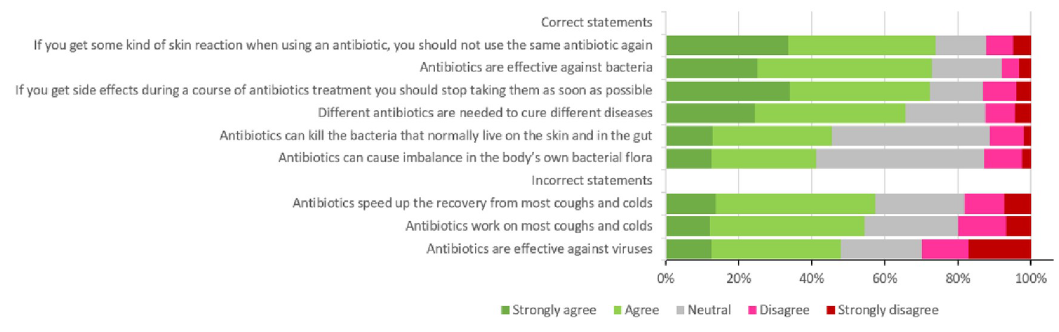
Fig 2. Respondents’ knowledge of antibiotic use.